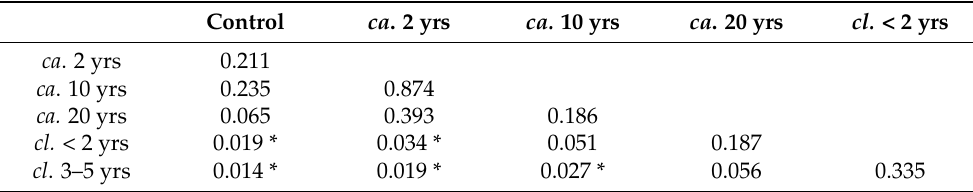
Table 3. Pairwise ANOSIM comparisons for the different treatment plots. Significant values are indicated by an asterisk.